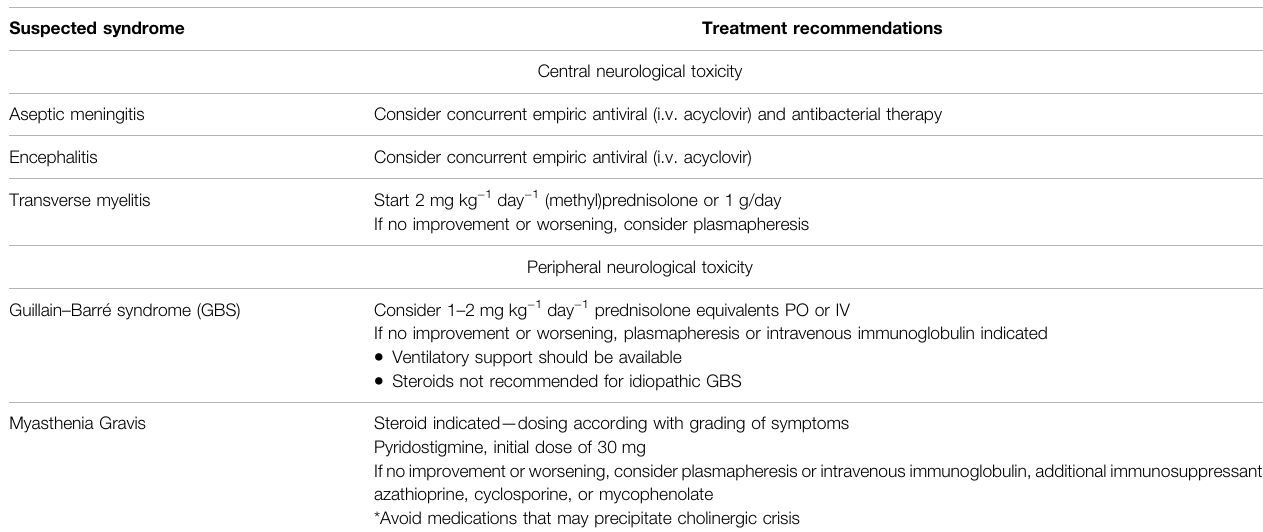
TABLE 4 | Other treatment recommendations for suspected immune-related neurological